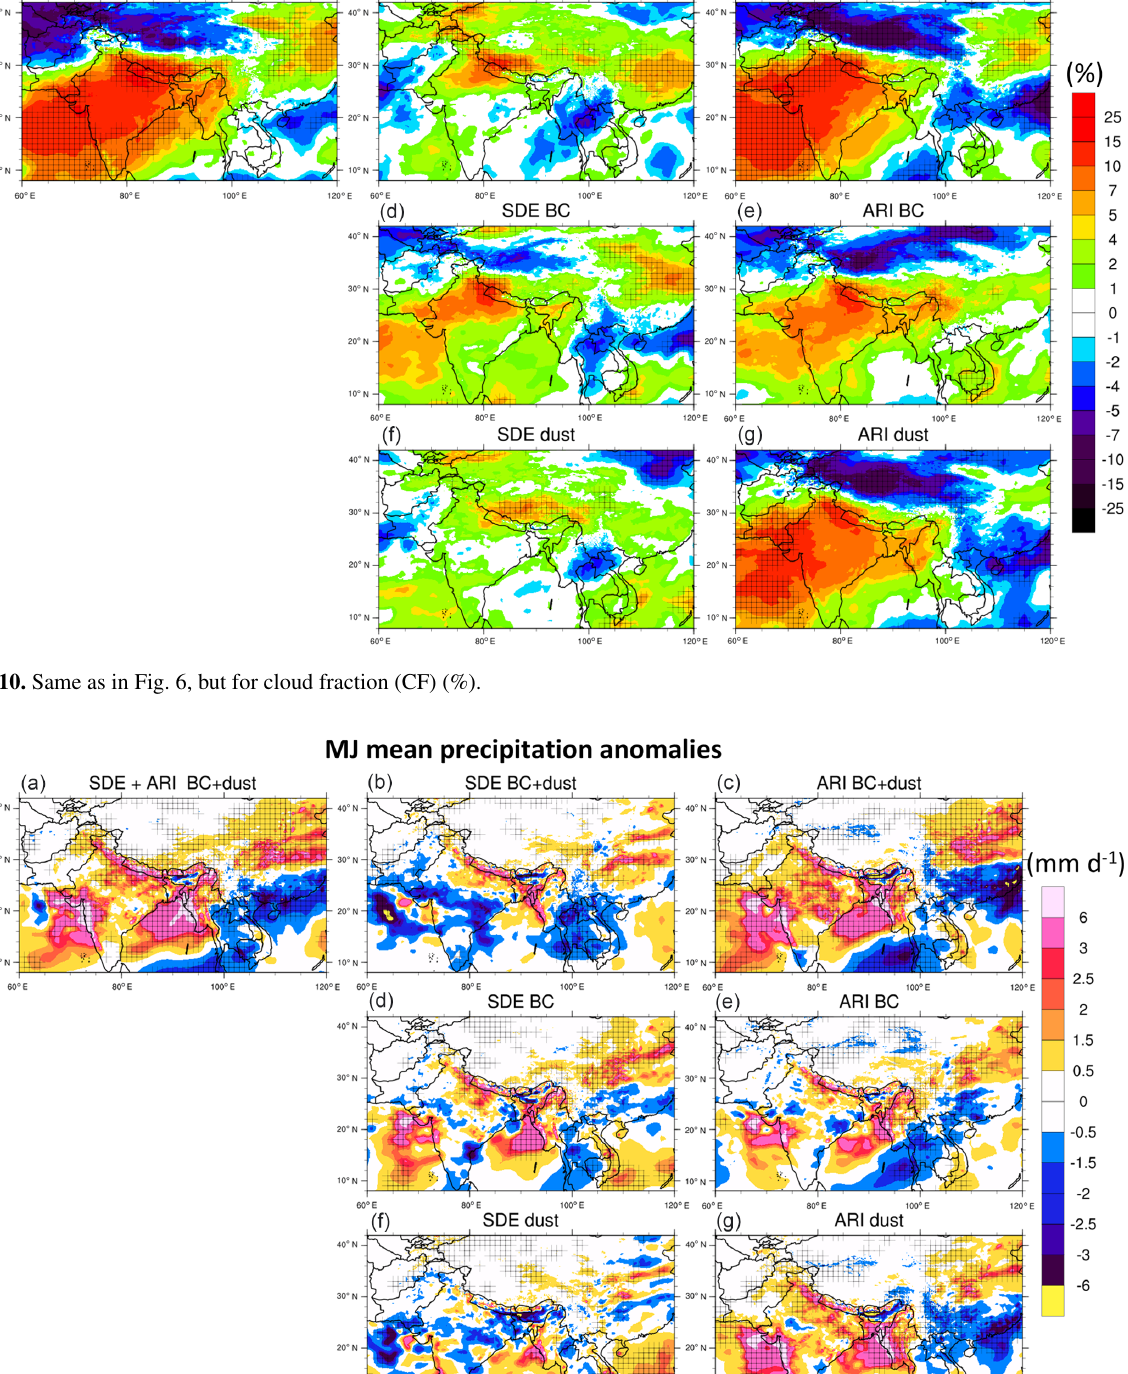
www.atmos-chem-phys.net/19/12025/2019/ Atmos. Chem. Phys., 19, 12025–12049,